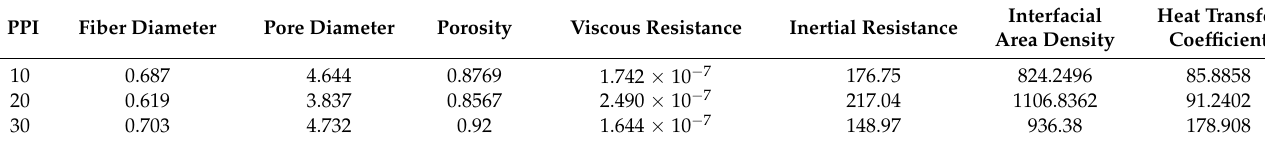
Table 6. Properties of metal foam